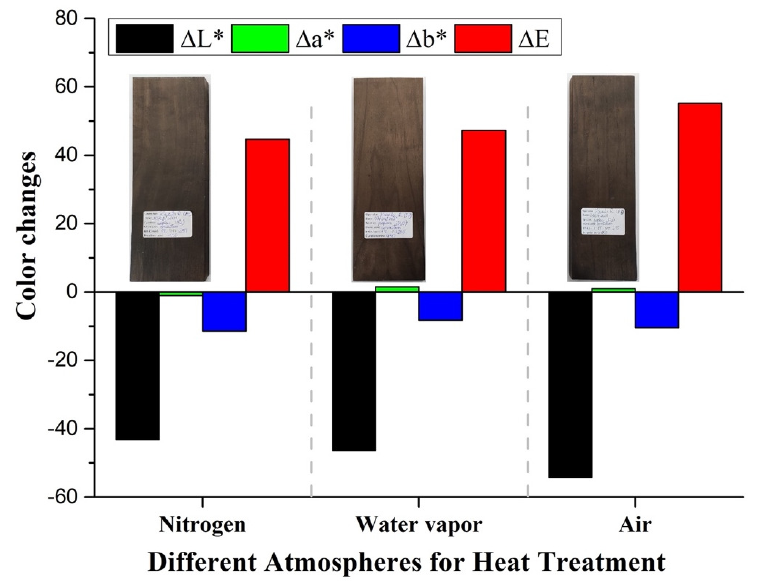
Figure 4. ∆ L*, ∆ a*, and ∆ b*, and ∆ E for samples treated under Nitrogen, water vapor, and air Figure 4. ∆L*, ∆a*, and ∆b*, and ∆E for samples treated under Nitrogen, water vapor, and air atmos- atmospheres.